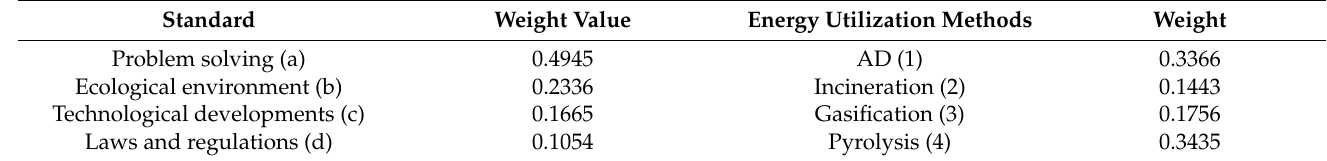
Table 3. Binary comparison weight values for each standard and energy utilization